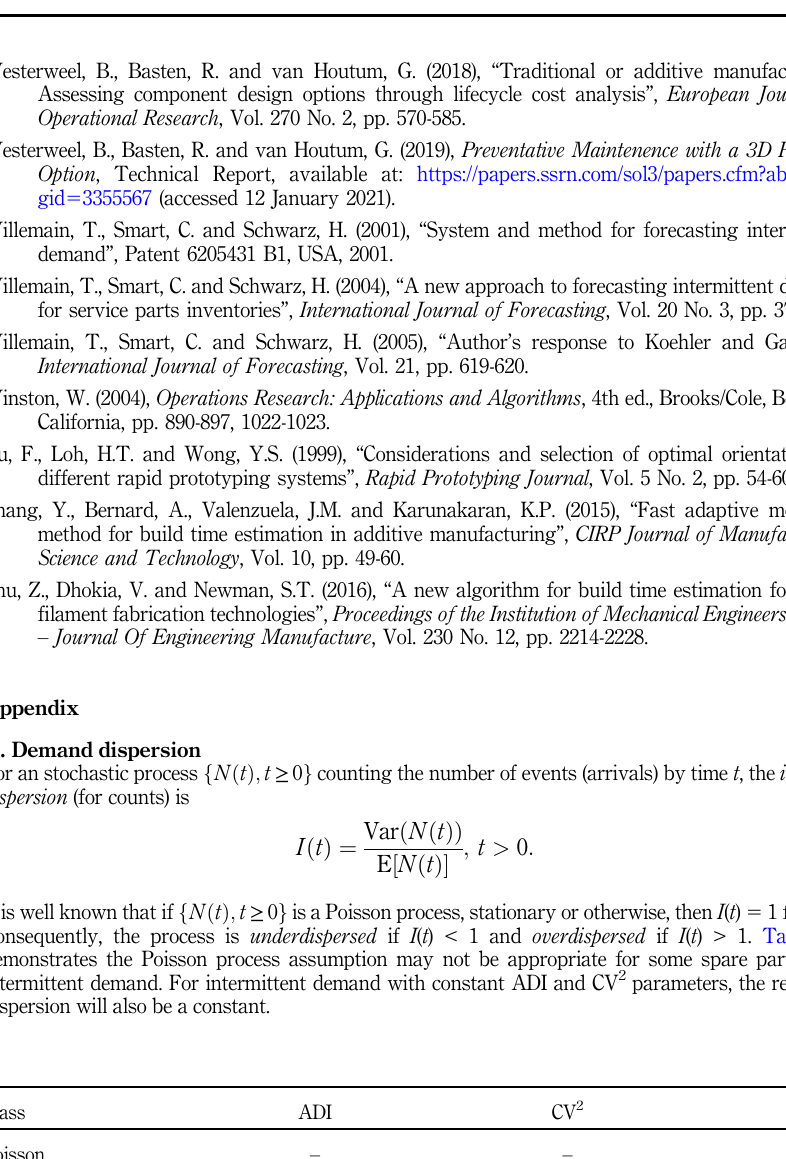
Table A1. Demand dispersion for various intermittent demand streams (50k sample paths over 30 days horizon, average level 5